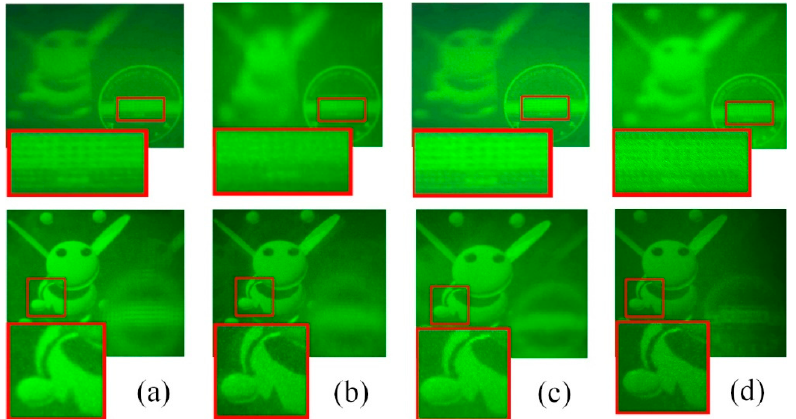
Figure 9. ( a ) Optical reconstruction results with pixel size Δ x 1 = 5 μ m. ( b ) Optical reconstruction results with pixel size Δ x 1 = 2.5 μ m. ( c ) Optical reconstruction results with pixel size Δ x 1 = 2.5 μ m and aperture filtering. ( d ) Optical reconstruction results with pixel size Δ x 1 = 2.5 μ m and partial aperture filtering.